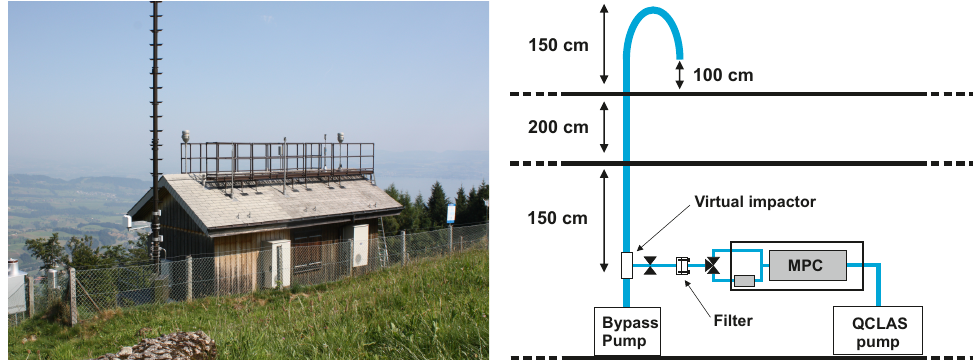
Figure 3. Left : Rigi measurement station as seen from the southeast. Right : schematic of the inlet and sampling